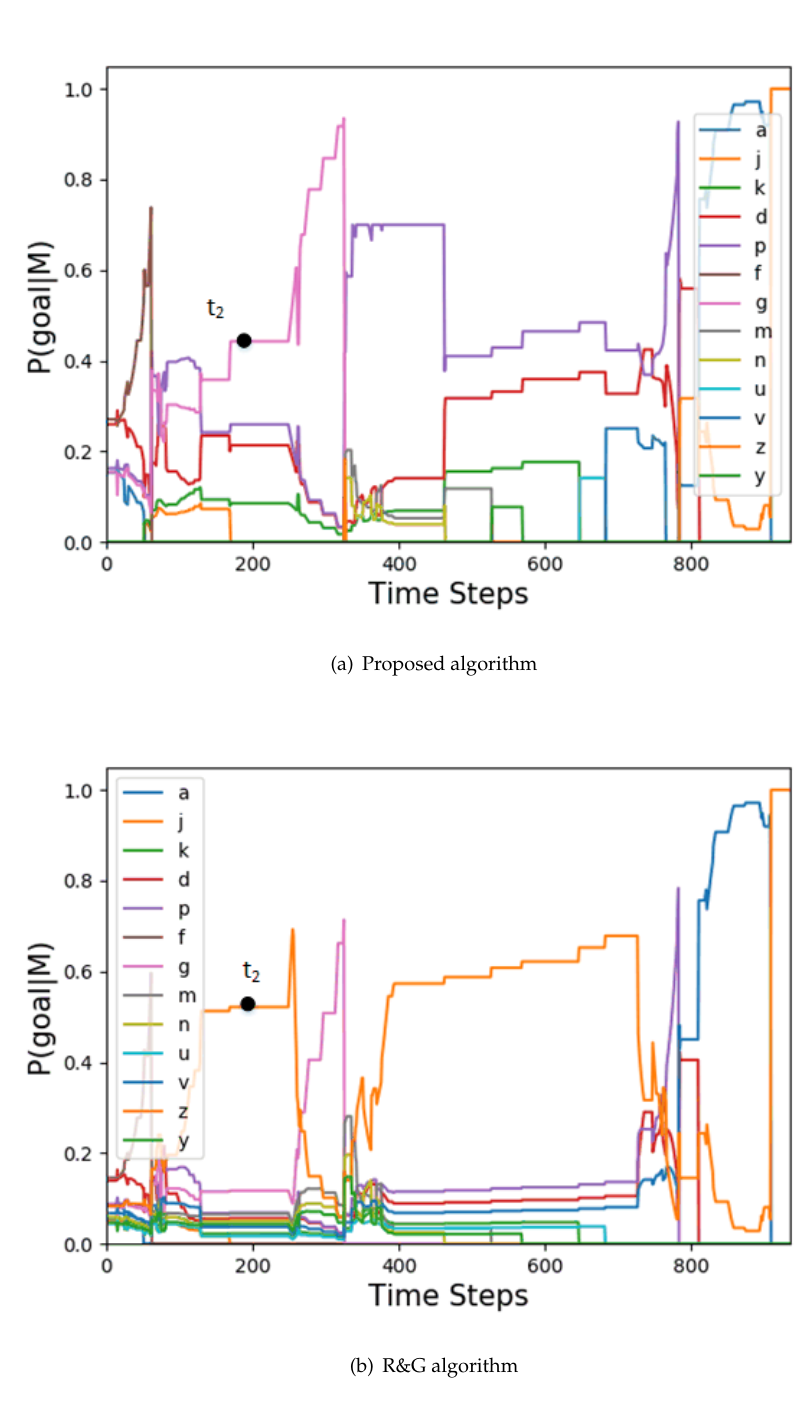
Figure 5. The goal probability curves of agent